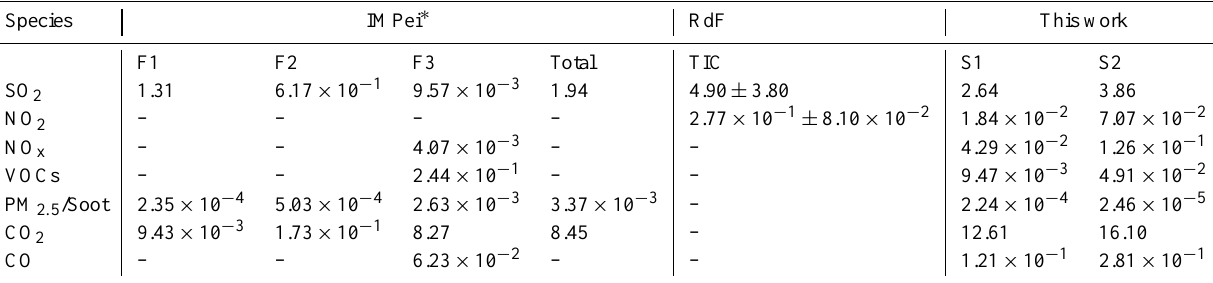
Table 2. Summary of the mass flow rates of combustion air pollutants. Units are in kilograms per second (kgs − 1 ). F1, F2, and F3 stands for Flare number 1, 2 and 3 respectively. RdF represents the combined reference of Rivera et al. (2009) and de Foy et al. (2009a). ∗ SO x